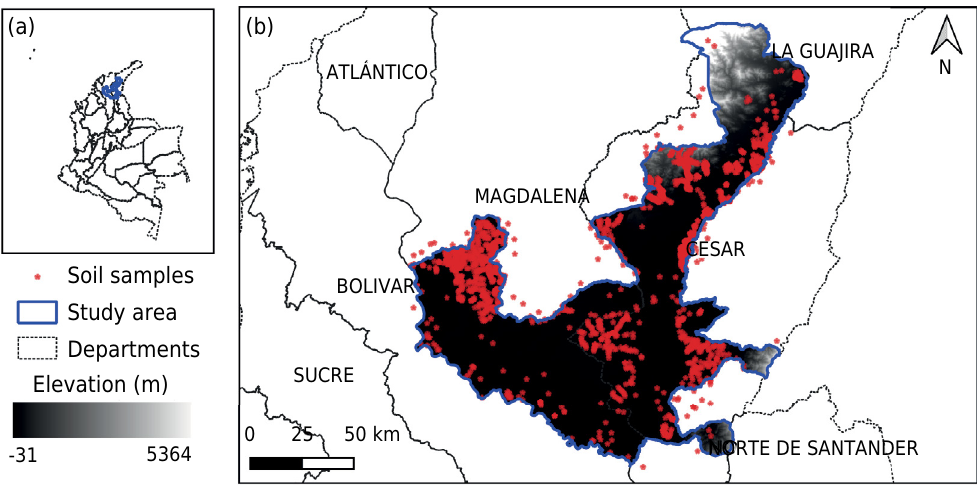
Figure 1. Location of the study area at national (a) and local (b) geographical extents. The internal divisions refer to administrative boundaries